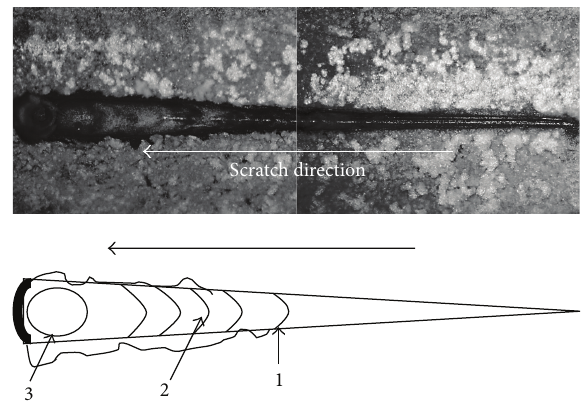
Figure6:FailuremodeofCaP/HAcoatedGP.(1)Archtensilecrack- ing, (2) delamination, and (3) total failure (recovery